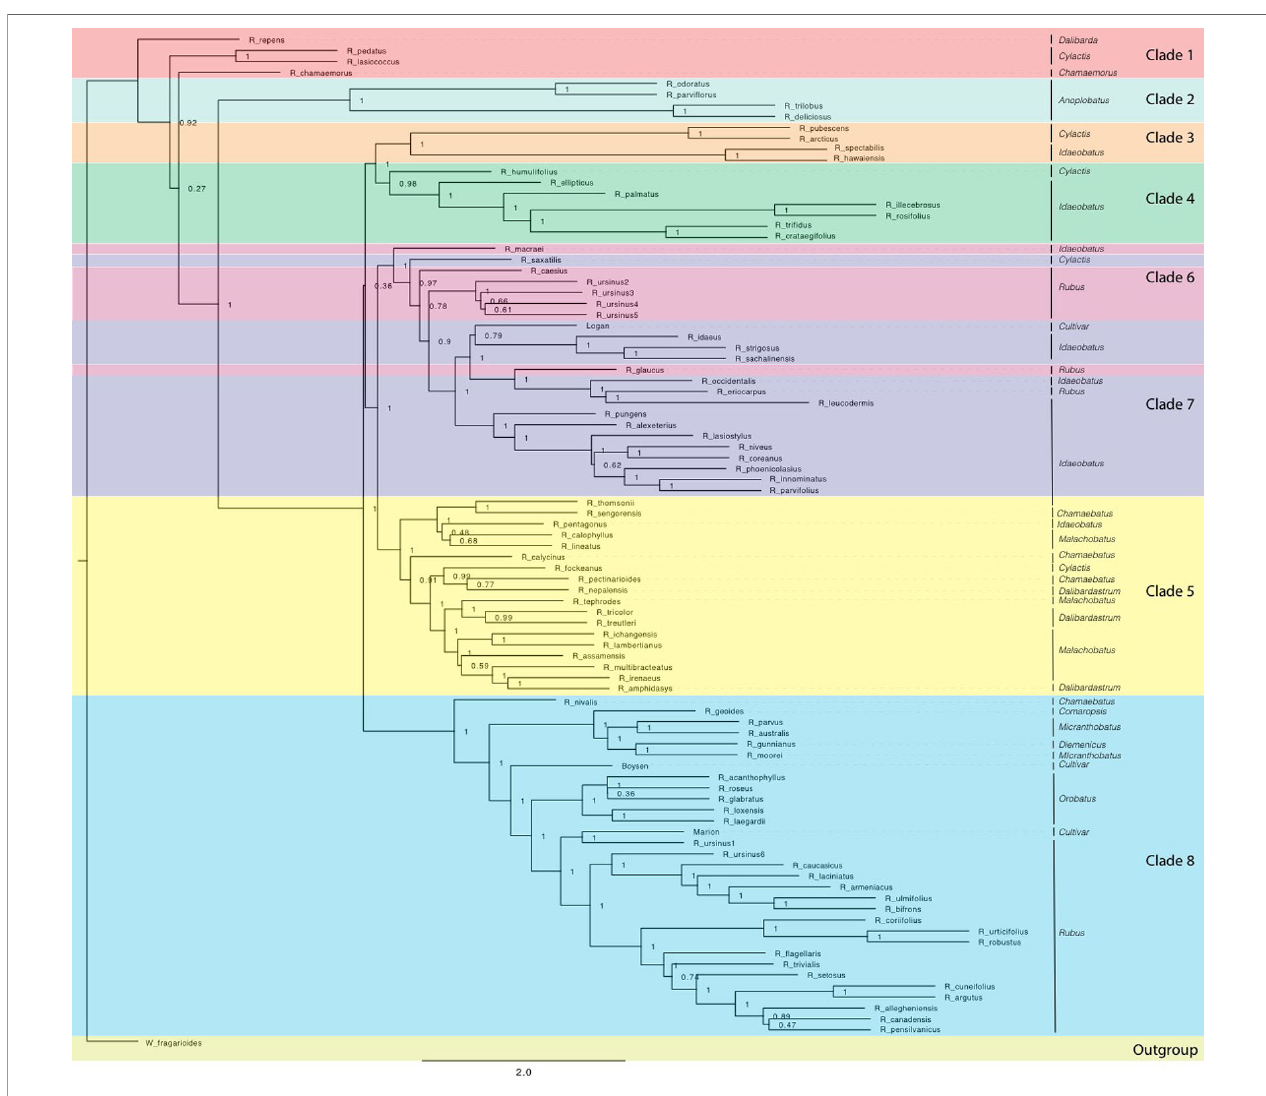
FIGURE 2 | ASTRAL-II phylogeny estimated from exon sequence gene trees from all Rubus taxa. Posterior probability values (0 – 1) are shown to the right of each node. Branch lengths are in coalescent units and measure discordance in the underlying gene trees. Groups are labelled with colored bands. Taxa are labelled with their subgeneric classi fi